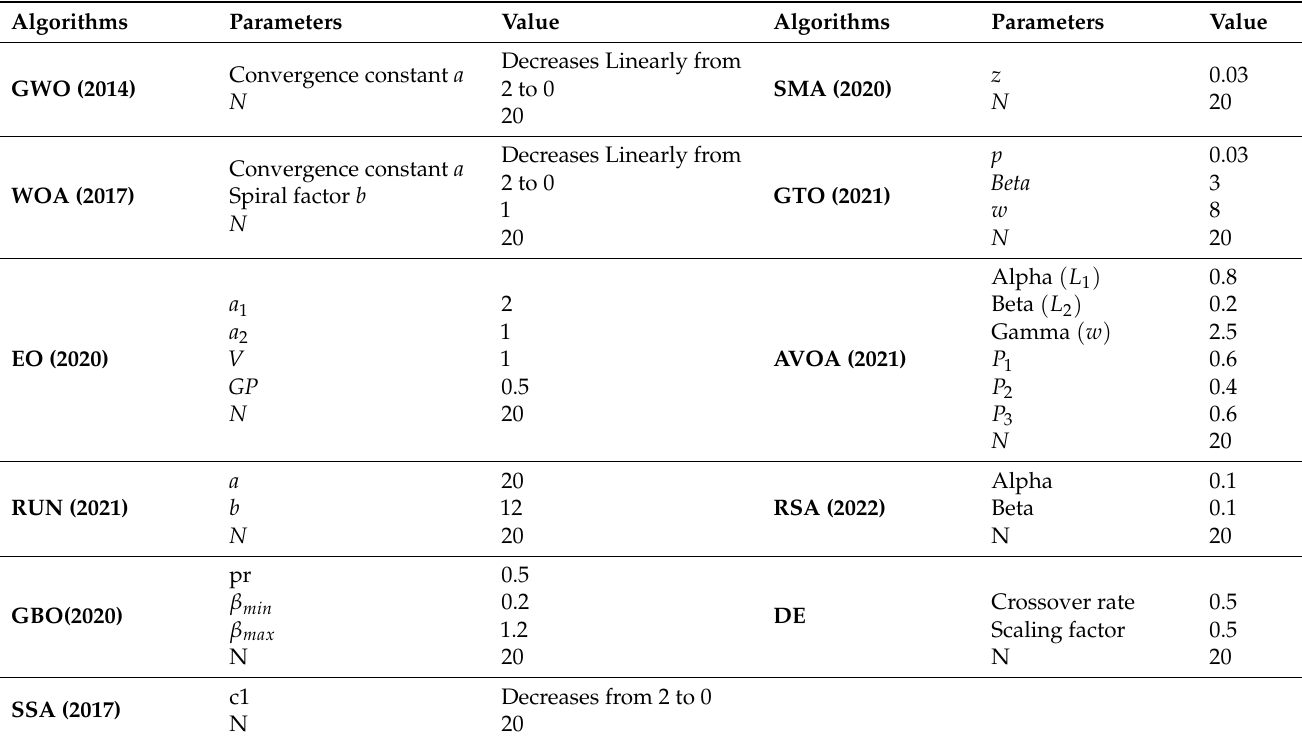
Table 5. Parameters of the compared